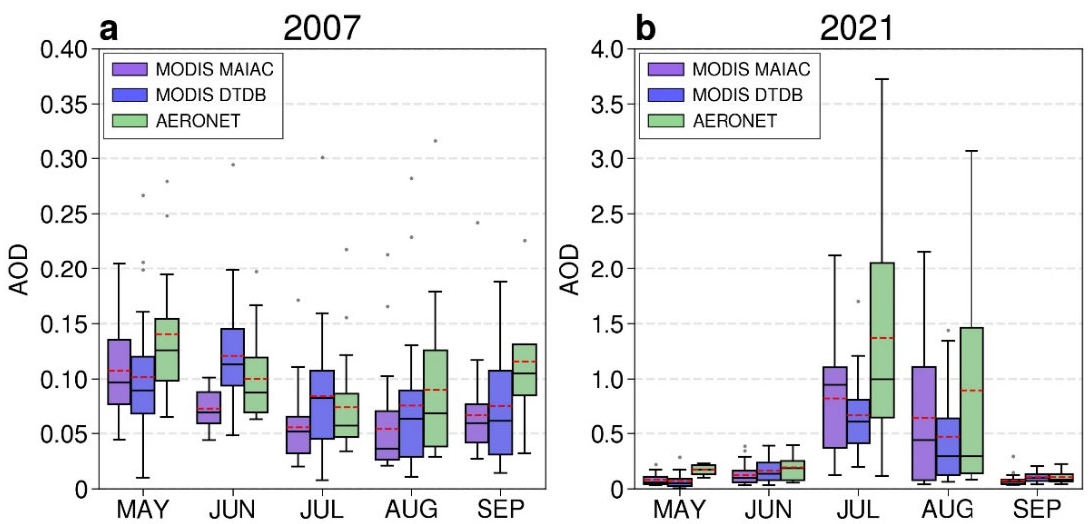
Figure 7. ( a ) Monthly statistics of aerosol optical depth from MODIS DTDB, MAIAC algorithms, and AERONET during 2007; ( b ) same but for 2021. MODIS AOD observations are averaged over the study region from daily data. Dashed red lines indicate the mean value. Note that figures ( a ) and ( b ) use different ranges on the y ‐ axes.